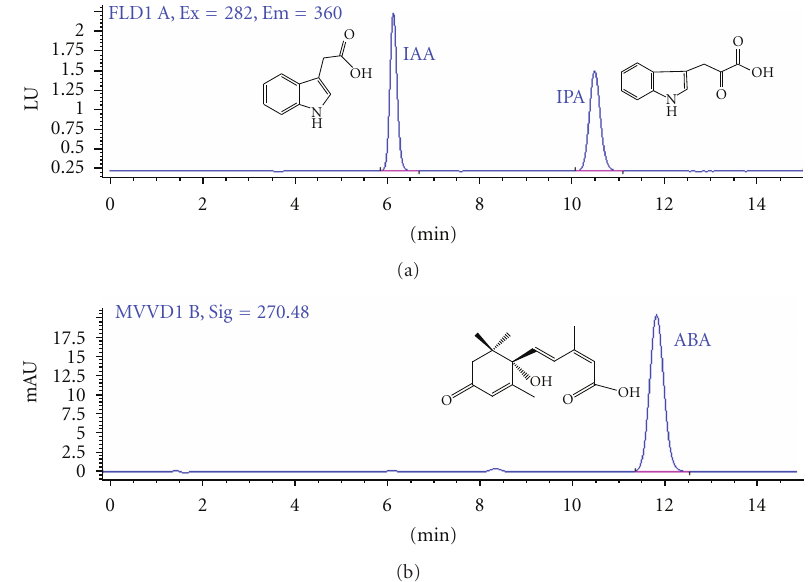
Figure 1: The chromatogram of isocratic separation of indole-3-acetic acid, indole-3-pyruvic acid, and abscisic acid in test mixture and their